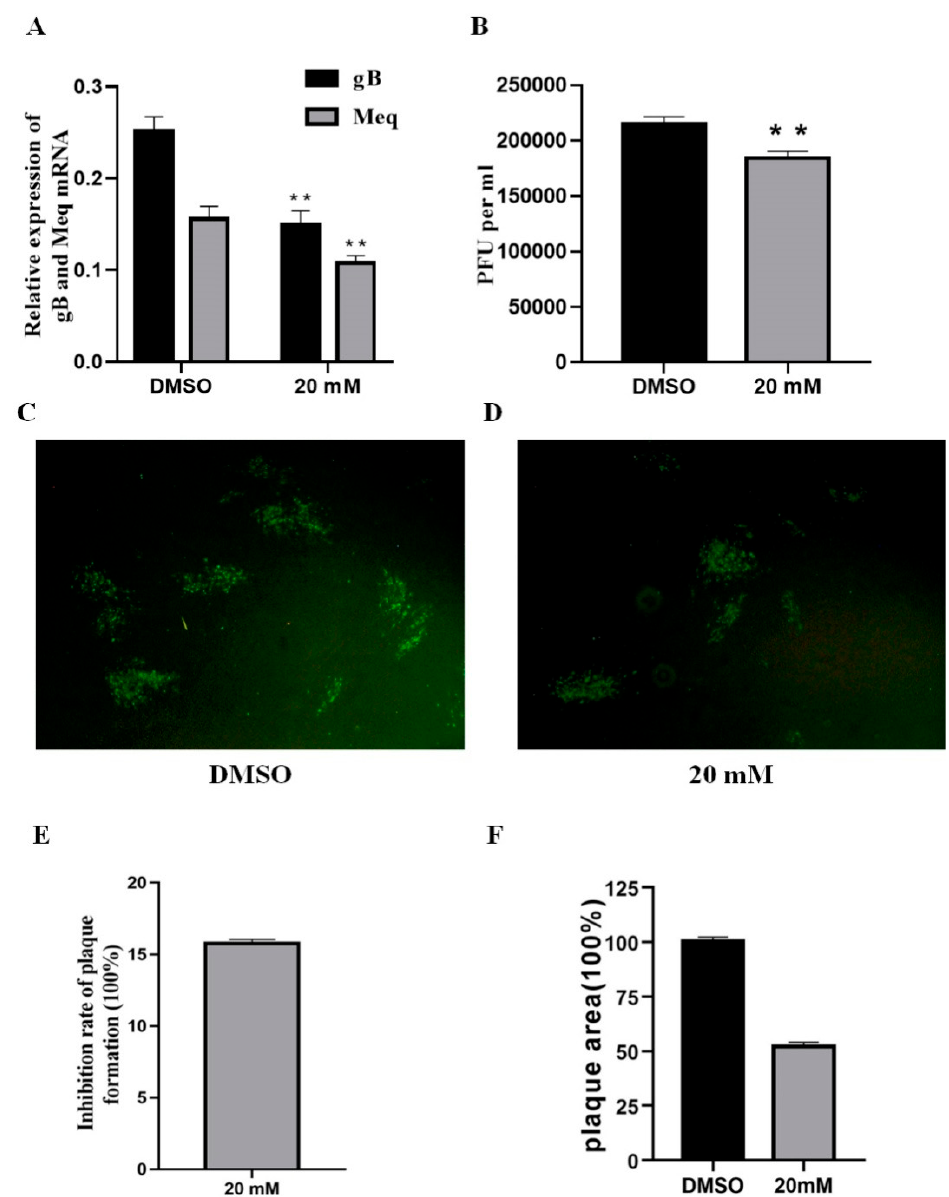
Figure 4. LiCl treatment pre-infection affects the infectivity of MDV. The mixture of 20 mM LiCl and MDV was incubated at 37 ◦ C for 1.5 h, and then inoculated in CEF until harvesting. ( A ). Detection of Meq and gB transcript level by RT-qPCR from RNAs of infected CEF. ( B ). Virus titration by plaque counting. The inhibition was observed by indirect immunofluorescence assay in DMSO group ( C ) and 20 mM LiCl group ( D ). ( E ). Inhibition rate was calculated and presented as relative to the DMSO group. ( F ). Plaque sizes (30 plaques) were measured, and presented as mean plaque sizes relative to the DMSO group. The mean plaque size of the DMSO group was set to 100%. The error bar represents the standard deviation of three independent experiments. The pictures were captured with an OLYMPUS microscope ( × 200). The data are expressed as the mean ± SD from three independent experiments, and analyzed by Student-t Test (** p < 0.01) for A and B.